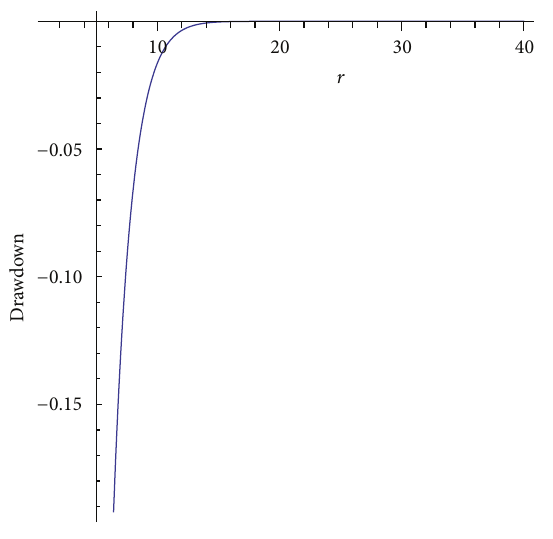
Figure 12: Barker’s solution.